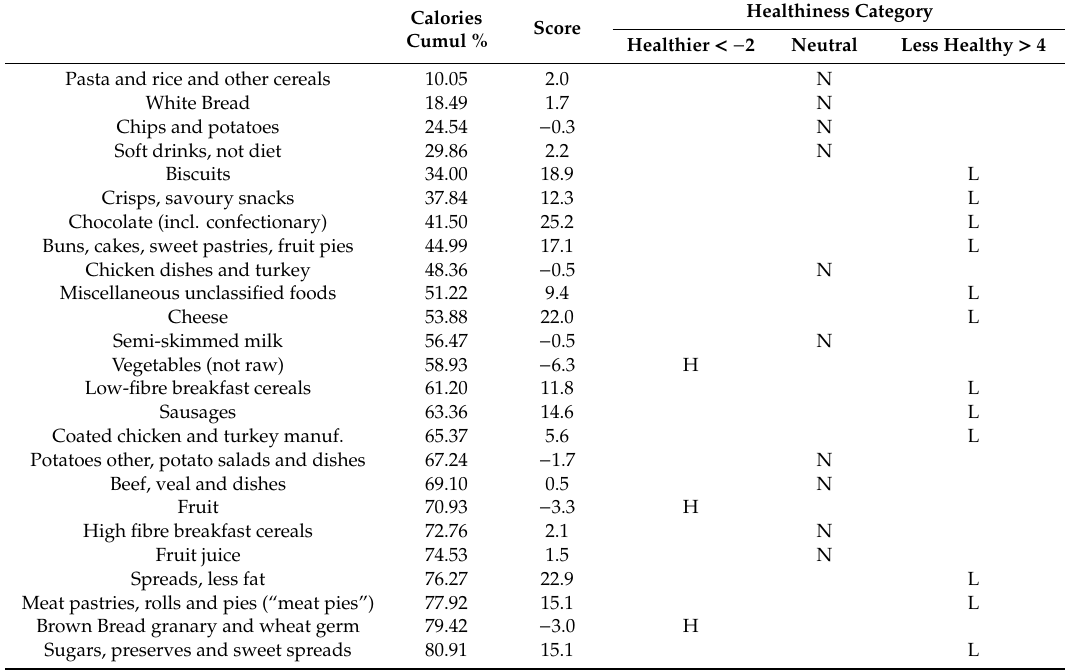
Table 1. Top 25 “P80” food groups sorted by increasing cumulative % of total calories consumed by adolescents in the NDNS-RP (2008–2012) and by FSA-adapted nutrient profile score